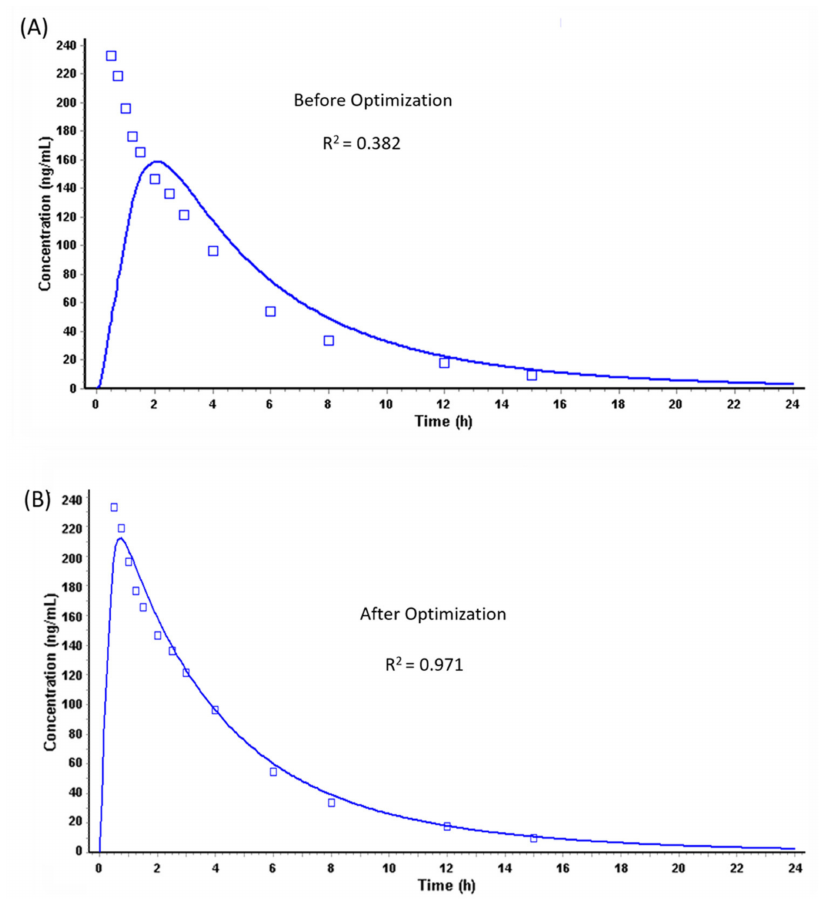
Figure 4. Riva plasma concentration–time profile from solution oral dose (10 mg) ( A ) before and ( B ) after optimization. Table 5. PK parameters obtained from simulated PK profiles. Parameter Actual (Reported) a PK parameters obtained from simulated PK profile of solution oral dose (10 mg) of Riva before and after